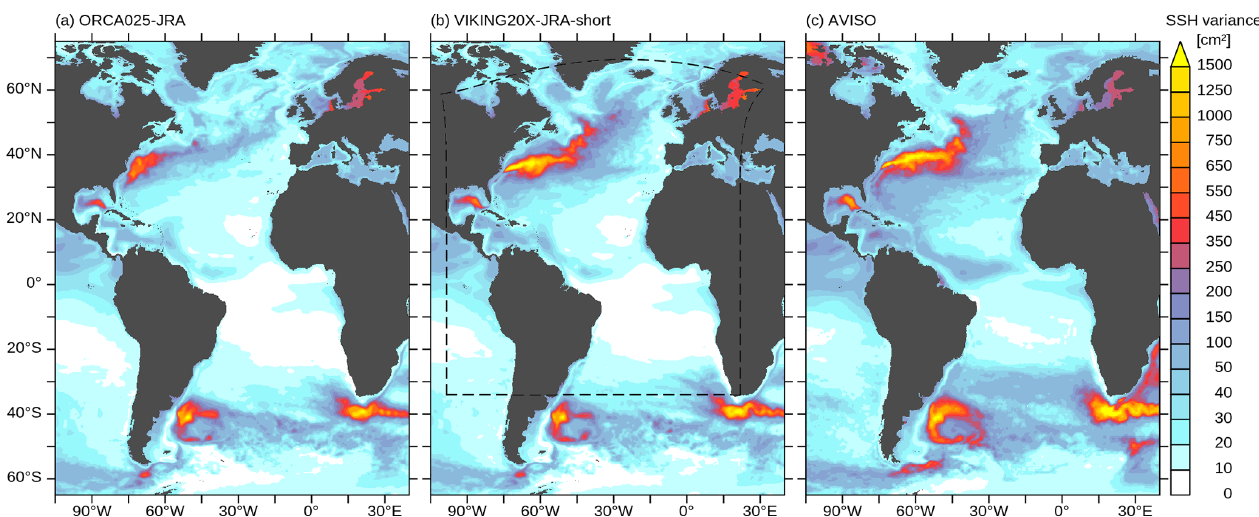
Figure 2. Variance of sea surface height (in cm 2 ) in (a) ORCA025-JRA, (b) VIKING20X-JRA-short and (c) satellite altimetry, calculated based on 5d averages over the period